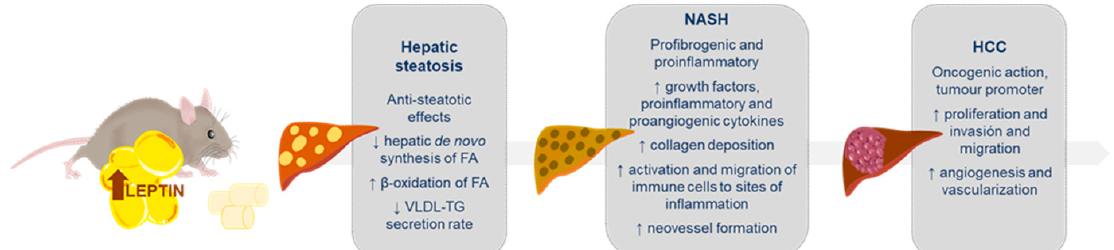
Figure 2. Summary showing the main changes induced by increased leptin in hepatic steatosis, non-alcoholic steatohepatitis and hepatocarcinoma. These metabolic changes can be upregulated ( ↑ ) or downregulated ( ↓ ) by the leptin action. FA (fatty acids); VLDL (very-low-density lipoproteins); TG (triglycerides); NASH (non-alcoholic steatohepatitis); HCC (hepatocarcinoma).